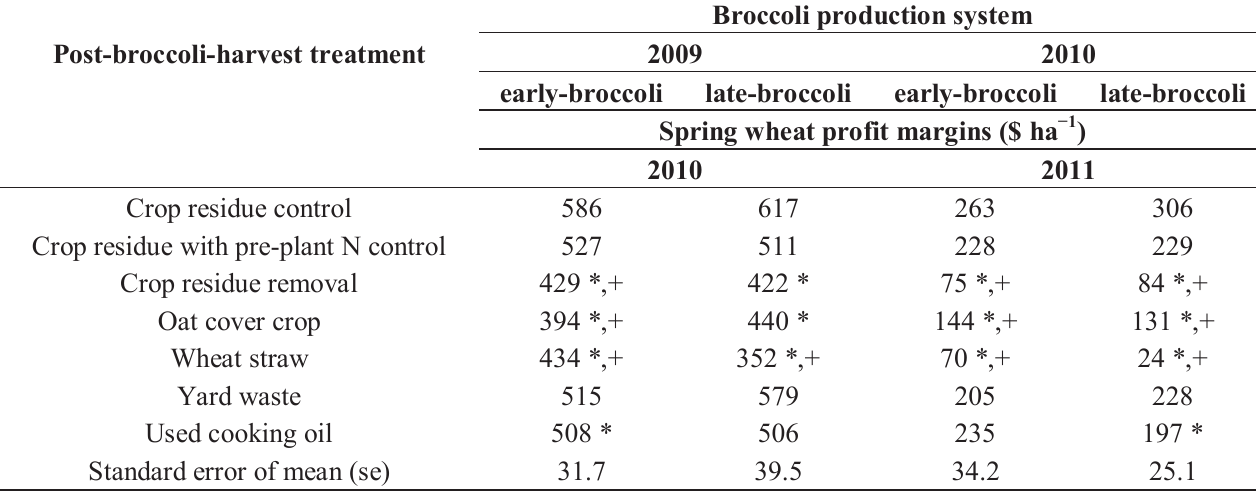
Symbols denote a significant difference ( P < 0.05) compared to the crop residue control * or to the crop residue with pre-plant N control +, based on a multiple means comparison with a Dunnett-Hsu